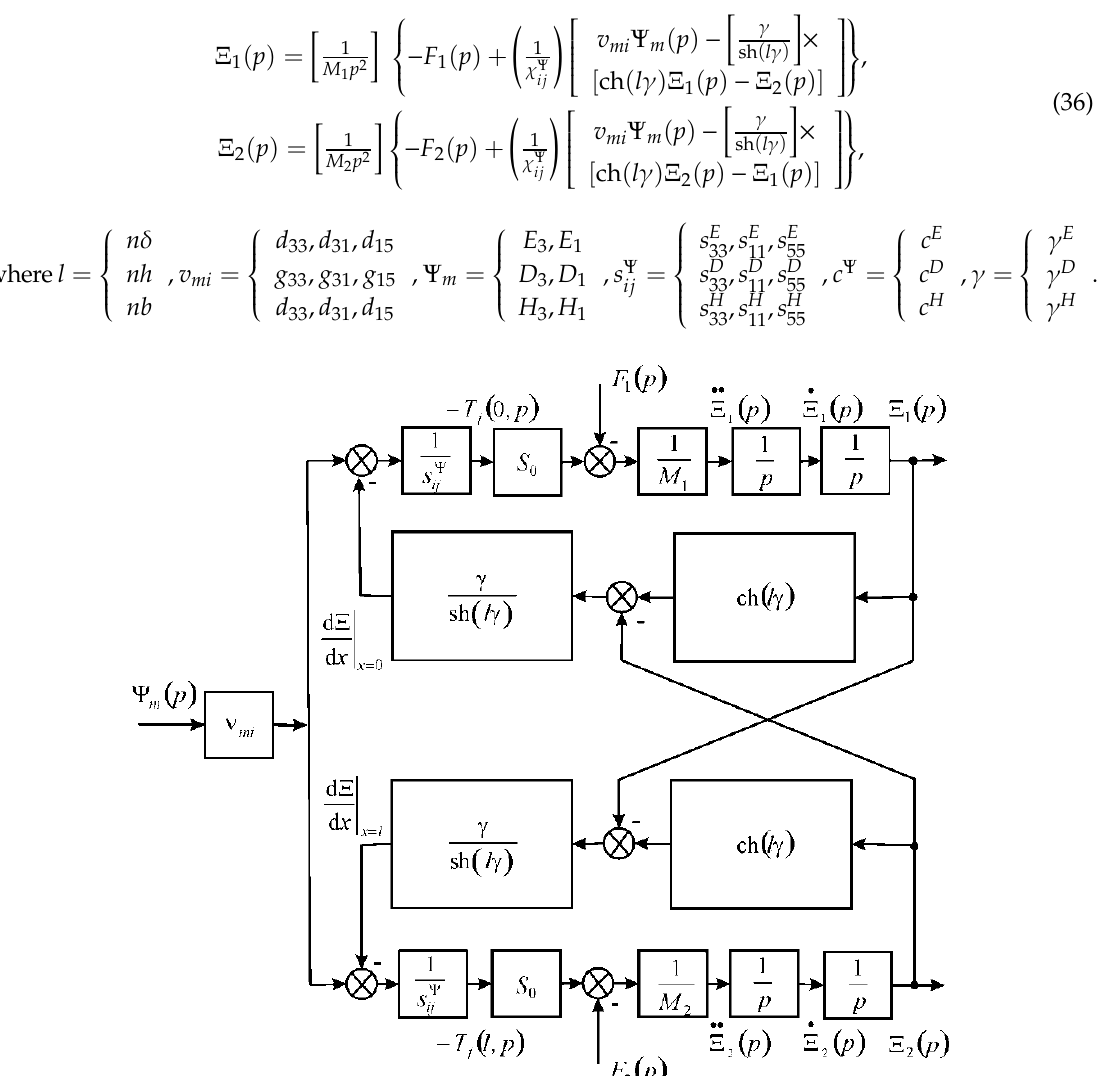
Figure 7. Generalized parametric structural schematic diagram of the multilayer electromagnetoelastic